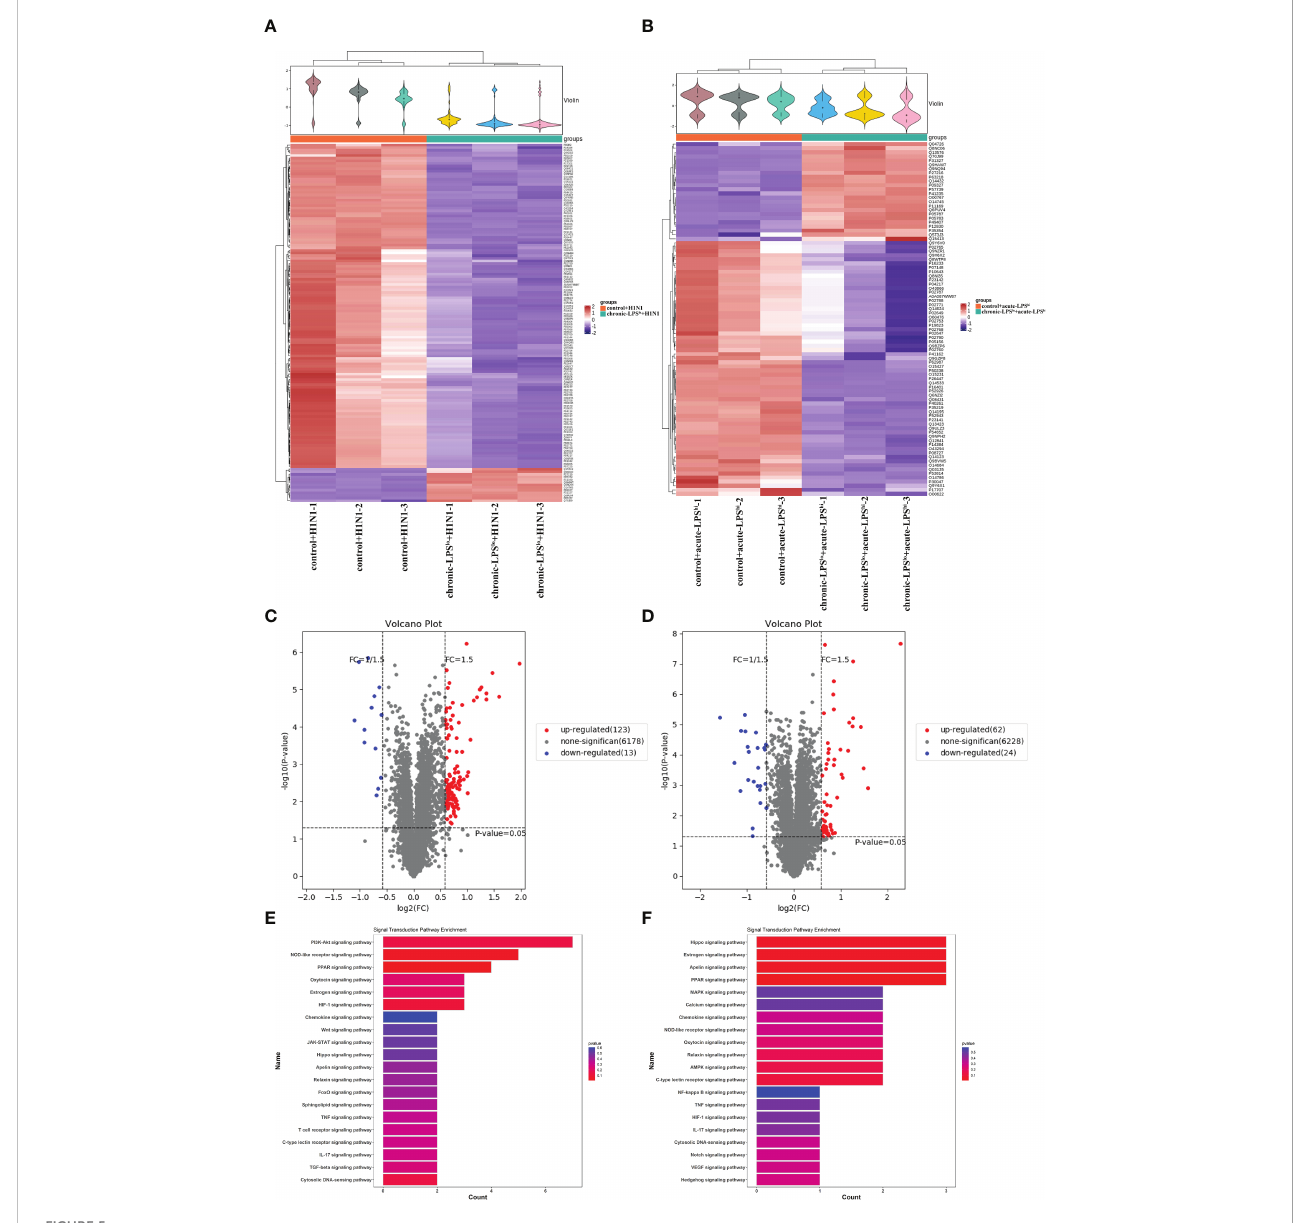
FIGURE 5 Inhibition of in fl ammation by chronic low-dose LPS stimulation is related to PPAR. (A) Hierarchical clustering analysis heat map in control+H1N1 group compared with chronic-LPS lo +H1N1 group. (B) Hierarchical clustering analysis heat map in control+acute-LPS hi group compared with chronic-LPS lo +acute-LPS hi group. (C) The differentially expressed proteins analyzed by volcano plots in control+H1N1 group compared with chronic-LPS lo +H1N1 group (vertical dotted lines, fold change > 1.5-fold; horizontal dotted line, p < 0.05). (D) The differentially expressed proteins analyzed by volcano plots in control+acute-LPS hi group compared with chronic-LPS lo +acute-LPS hi group (vertical dotted lines, fold change > 1.5-fold; horizontal dotted line, p < 0.05). (E) Top 20 of signaling transduction of KEGG pathway enrichment analysis in control+H1N1 group compared with chronic-LPS lo +H1N1 group. (F) Top 20 of signaling transduction of KEGG pathway enrichment analysis in control+acute-LPS hi group compared with chronic-LPS lo +acute-LPS hi